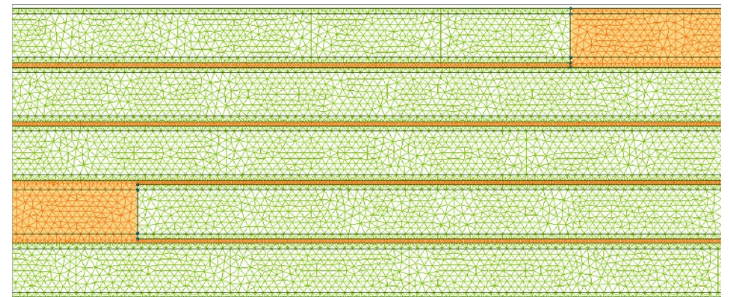
Figure 4. Sample of the triangular finite element